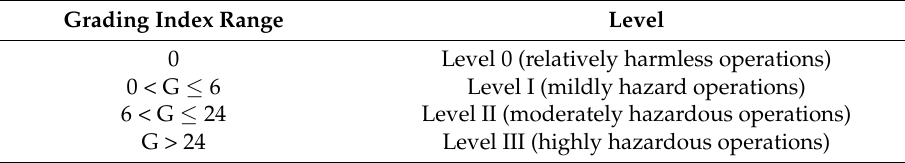
Table 3. The operation classification results of toxic and harmful